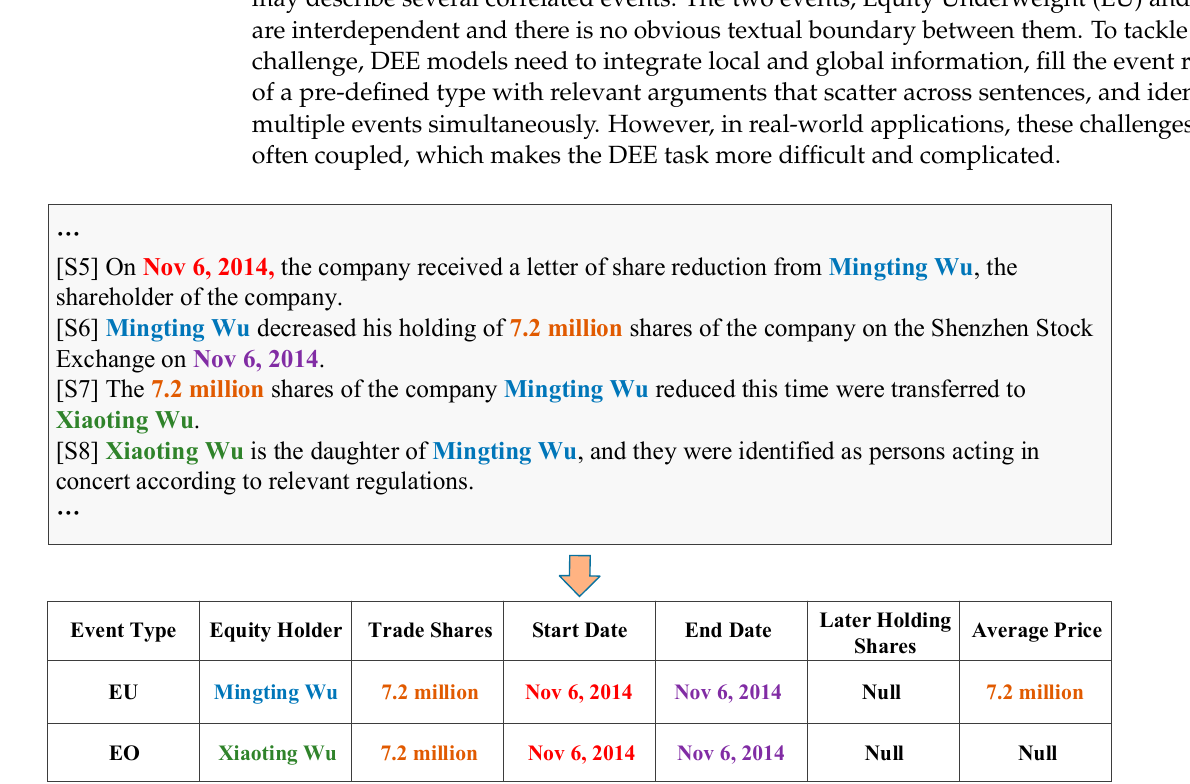
Figure 1. An example document from ChFinAnn proposed by Zheng et al. [8]. In the document, only four sentences (S5–S8) are shown, the lists Equity Underweight (EU) and Equity Overweight (EO) are extracted events, and the bold-faced and coloured words are event arguments with specific roles.